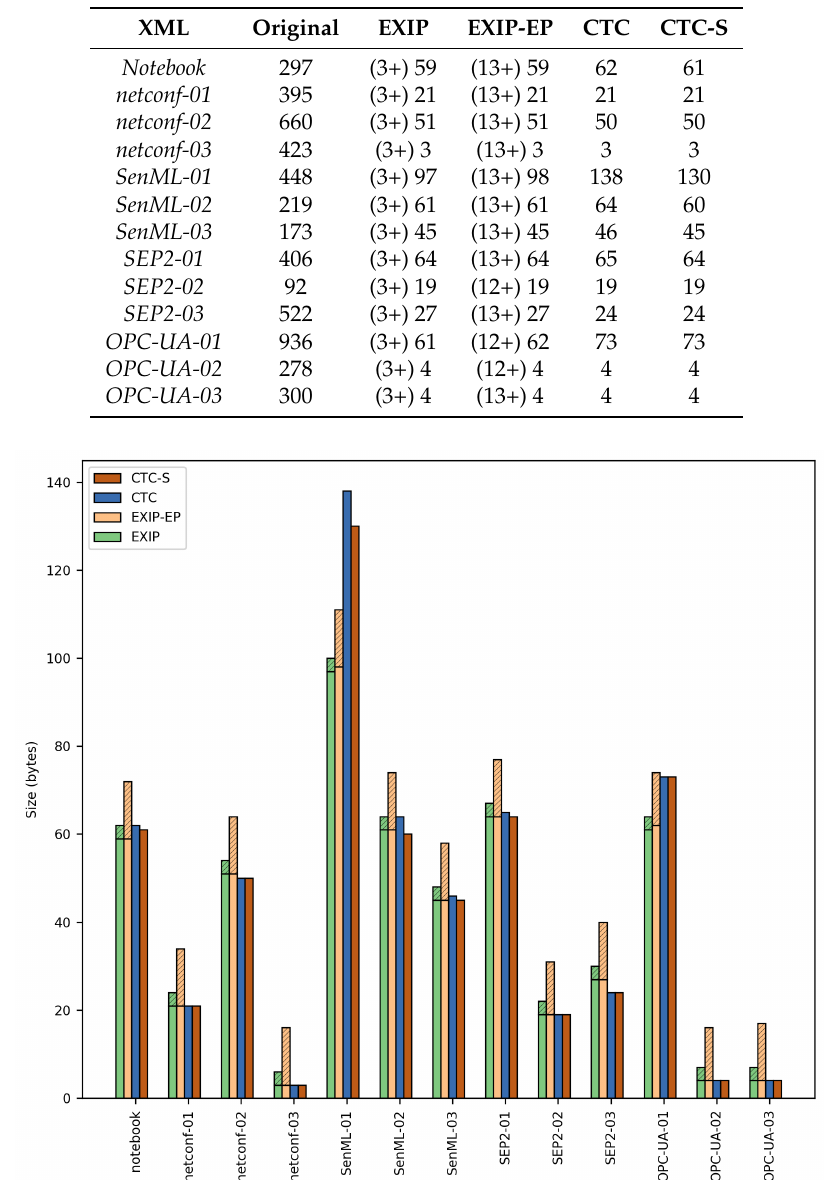
Table 3. XML document compression comparative in bytes. EXIP : schema strict mode, all preserve options to F ALSE and schemaId to constant string “1”. EXIP-EP : same options as EXIP column plus EXI Profile. CTC : CTC normal compression mode. CTC-S : CTC strict mode. Numbers inside brackets